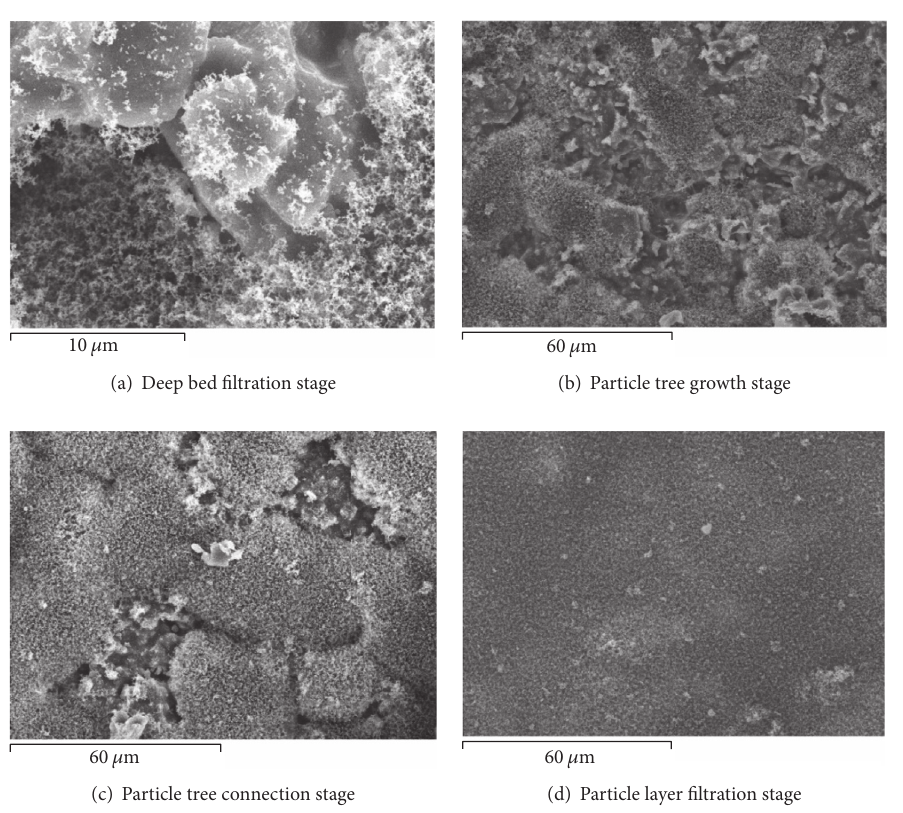
Figure 11: The SEM images of the surface of ceramic piece in different filtration stage (particle source: CF5000LN; filtration temp. = 200 ∘ C; filtration velocity = 0.02 m/s; #1 ceramic